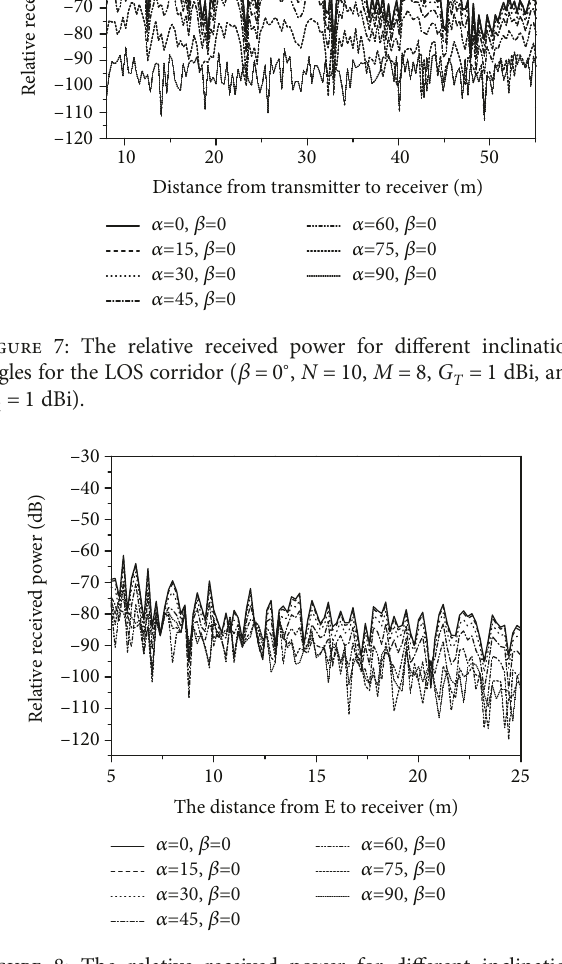
Figure 8: The relative received power for di ff erent inclination angles for the NLOS corridor ( β = 0 ∘ , N = 10 , M = 8 , G T = 13 dBi, and G R = 1